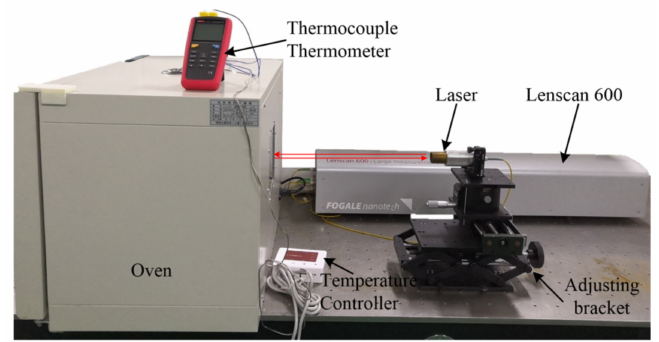
Figure 2. Actual experimental setup. The oven, thermocouple thermometer heating plate, and temperature controller form the heating system. The Lenscan 600 (Nimes, France) was used to measure the distance.